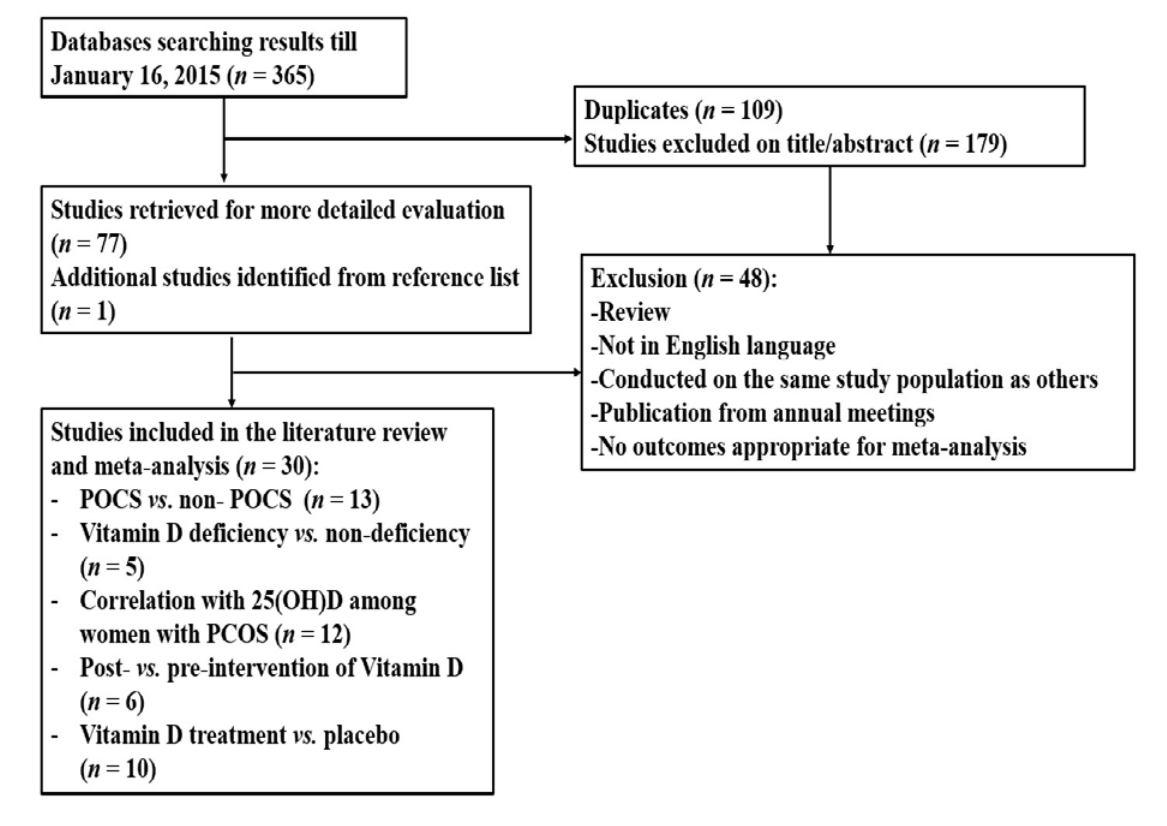
Figure 1. Flowchart of literature